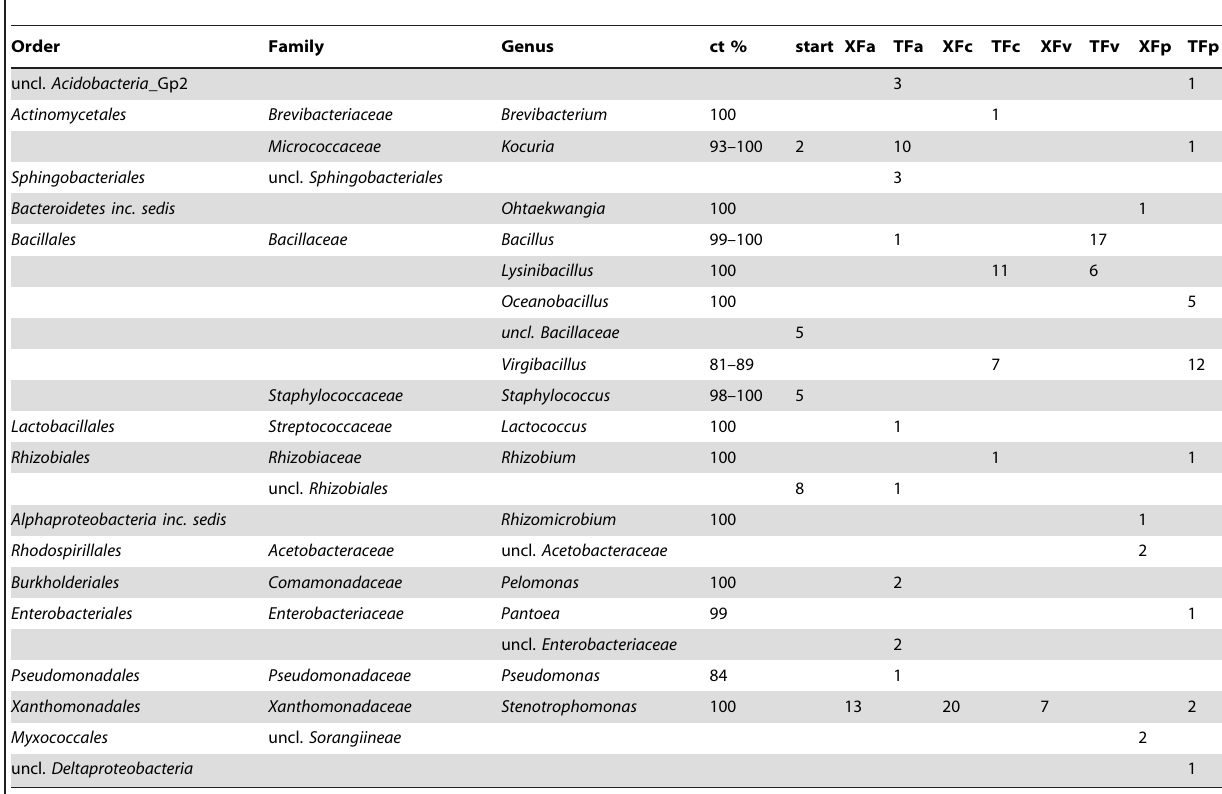
Table 1. The identification and the numbers of bacterial clones obtained from the samples; the classification reliability is given by confidence threshold (ct) value (RDP Classifier,